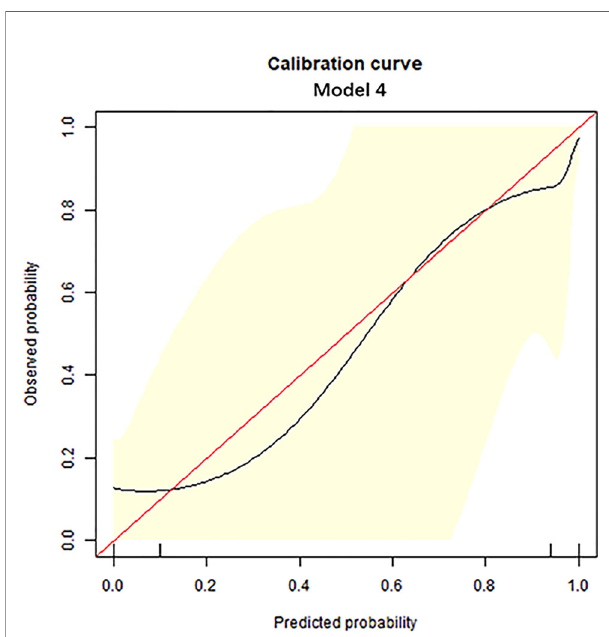
FIGURE 3 | Calibration curve analysis. The calibration curve was used to show the relationship between the predicted value and the true value. The x - axis represents the predicted probability, while the y- axis represents observed probability. The red line represents the ideal calibration line, and the black line represents the predictive power of the nomogram. The closer the black line is to the red line, the better the predictive power of the